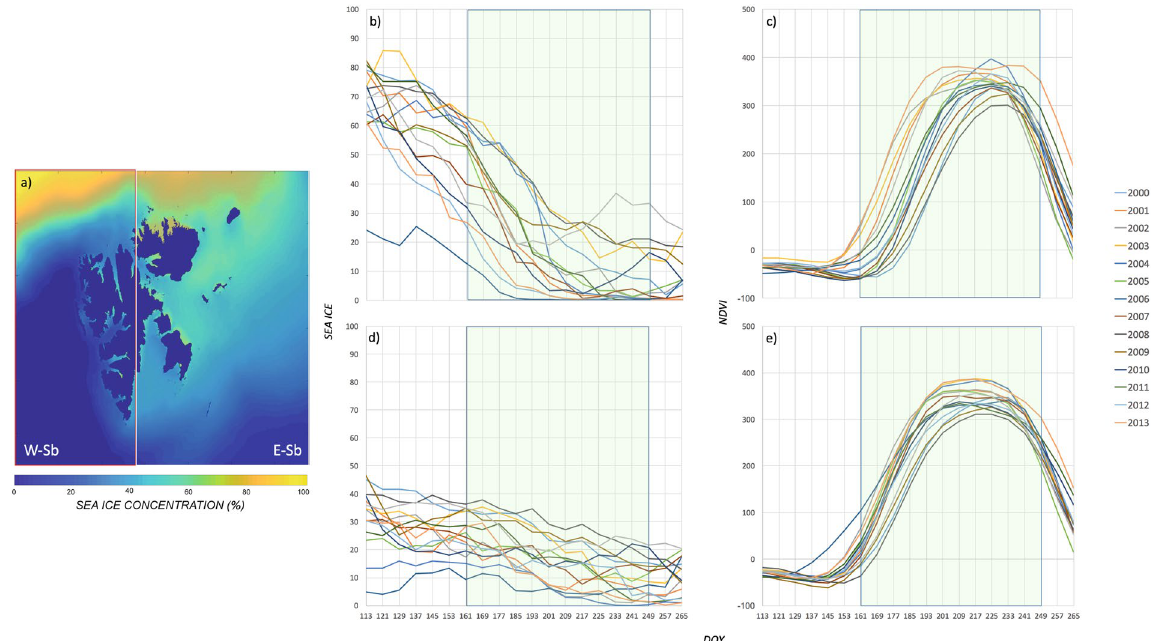
Figure 2. Sea ice and NDVI variability in W- & E-Sb . ( a ) Map of the Svalbard Archipelago depicting mean sea ice concentration for the period 2000–2014 and the extent of W-Sb & E-Sb . Eight-day mean sea ice concentration and NDVI values are shown for E-Sb (b , c ) and W-Sb ( d , e ) for each year from 2000 to 2014 during the period of the year for which good quality data is available (Day-of-Year, DOY 113 – April 23 to DOY 273